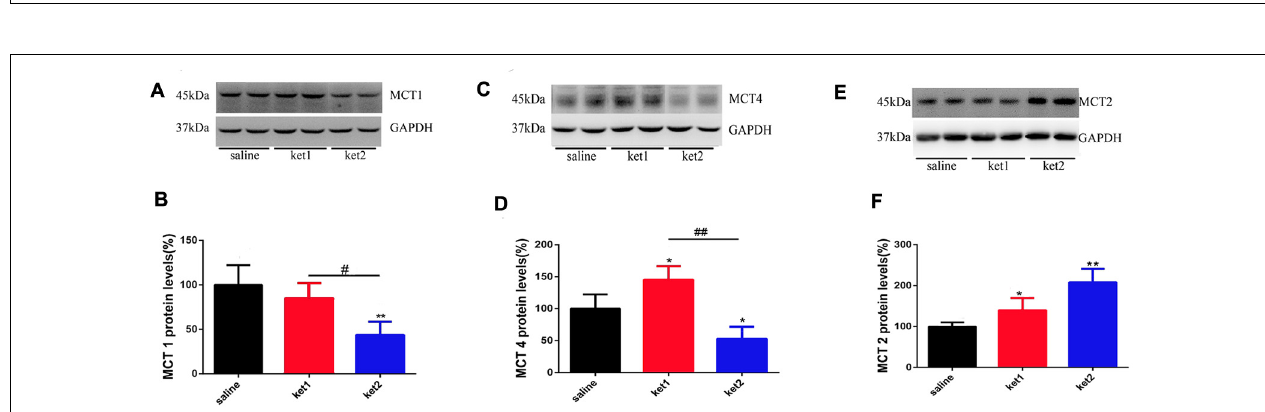
FIGURE 3 | Spatial working memory performance of mice in RAM tests following 6 months of ketamine administration with different doses of ketamine 30 mg/kg and 60 mg/kg. (A) No significance of time spent in finishing a session was seen in three groups. (B) Significant increase of total errors in one session to accomplish a RAM test in ket2 group comparing with the control group ( F (2,37) = 3.718, * p < 0.05). (C–E) Representative searching tracks of mice with different treatments in the RAM test acquisition trails (saline n = 14, ket1 n = 13, ket2 n = 13).